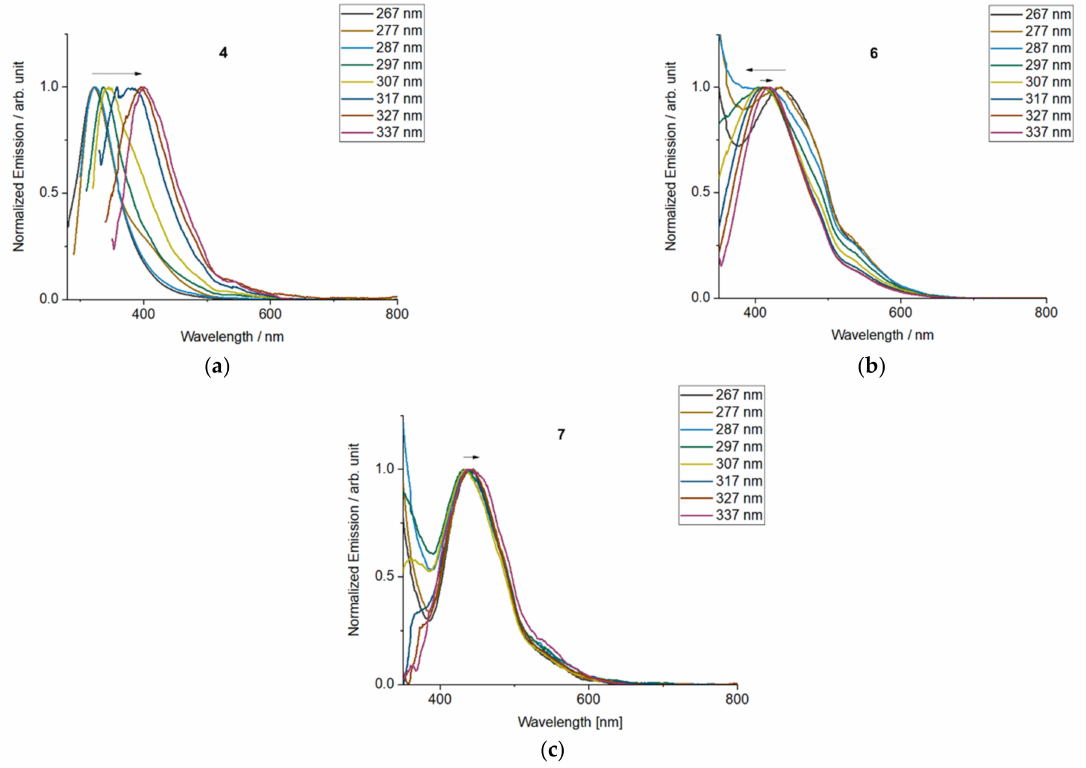
Figure 5. Room-temperature emission spectra of 4 ( a ), 6 ( b ) and 7 ( c ) in solution after excitation at varying wavelengths (10 − 5 M in CH 3